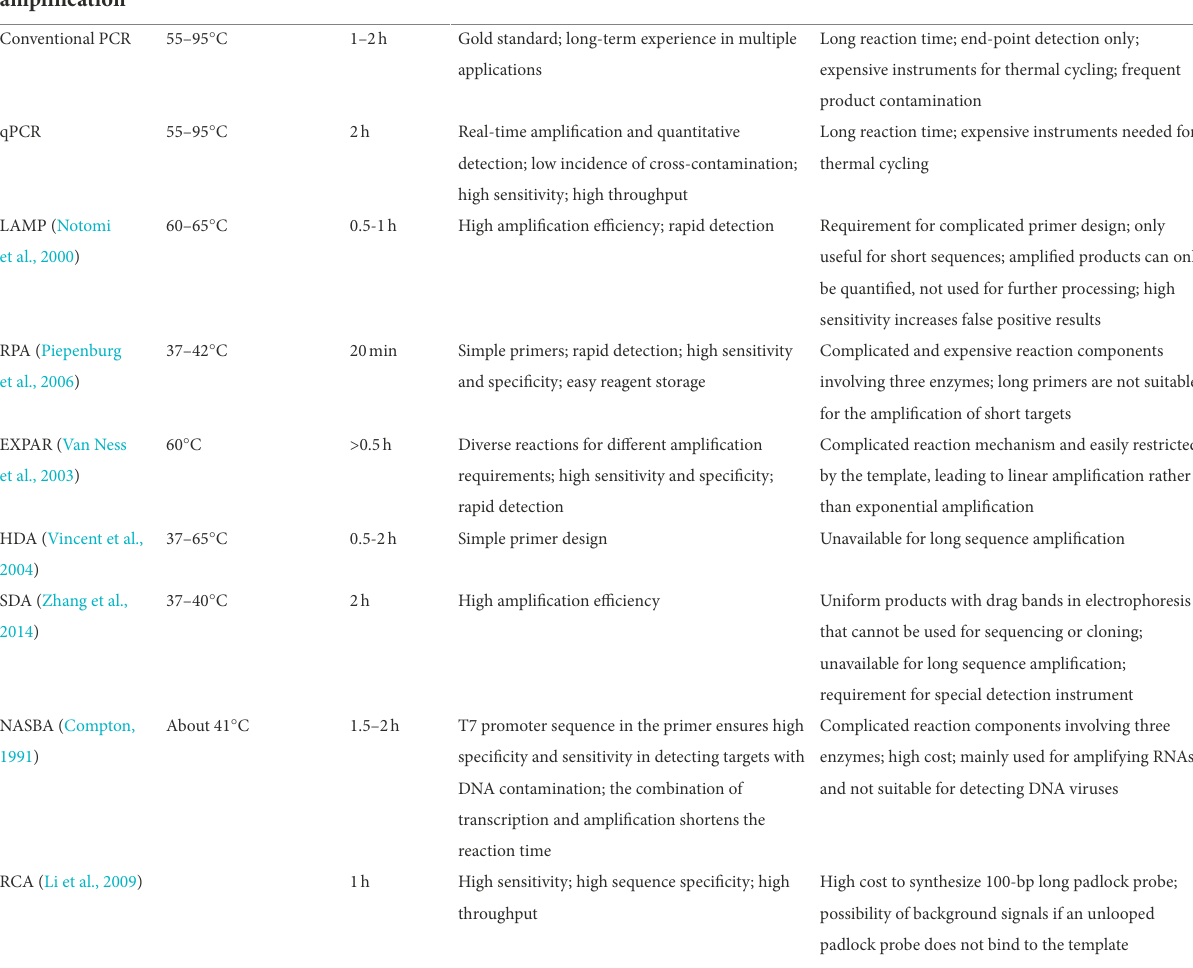
TABLE 2 Advantages and disadvantages of various nucleic acid amplification